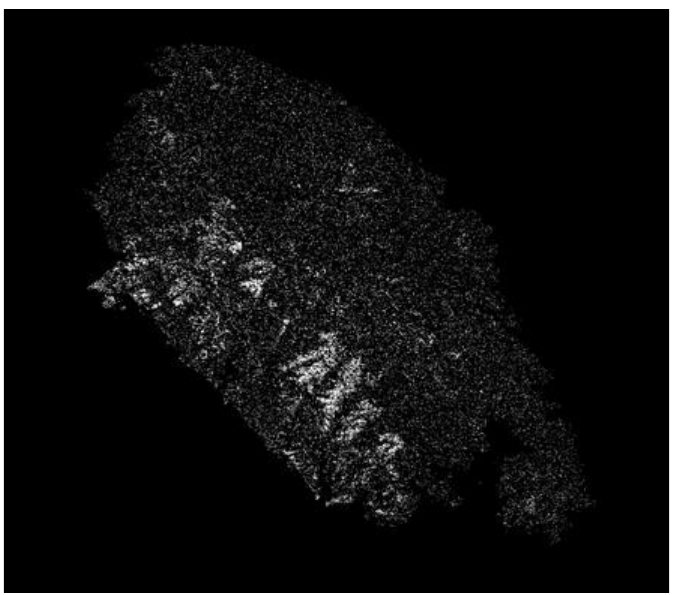
Figure 6. SAR based pseudo label for CZU Lightning Complex study area, image dated August